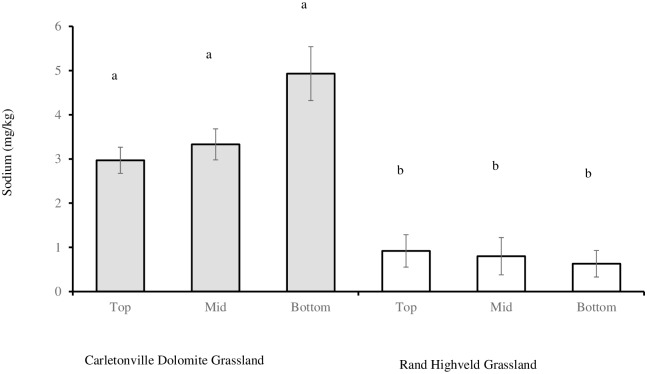
Soil sodium content at CDG (n = 33) and RHG (n = 35) slopes sites.Bars represent standard error (SE). Same letters on the bars indicate that P > 0.05.